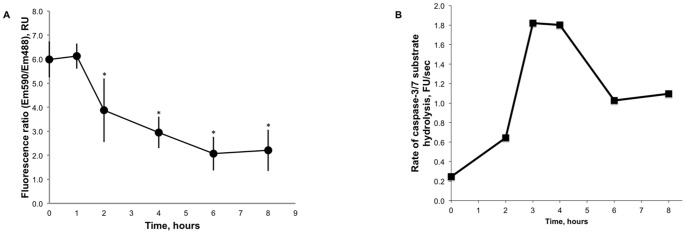
Endothelial apoptosis.HUVECs were treated at 37°C and 5% CO2 with 10 ng/ml IL-1ß in the presence of 10 µg/ml actinomycin D for 0–8 hours in supplemented EGM-2 medium. Panel A shows the inhibition of mitochondrial transmembrane potential by a mixture of IL-1ß with actinomycin D. Mitochondrial transmembrane potential was assayed as the ratio of JC-1 dye located in mitochondria (emission wavelength 590 nM) to cytosol bound JC-1 (emission wavelength 488 nM). Data shown are the averages and standard deviations of four assays. Asterisks mark statistically significant changes (p-value <0.05) in JC-1 dye distribution. Panel B shows caspase-3/7 activation in HUVECs treated with IL-1ß in the presence of actinomycin D for 0, 2, 4, 6 and 8 hours. Caspase activity was determined as the rate of hydrolysis of caspase specific fluorogenic substrates. Data shown are the averages of two independent assays.